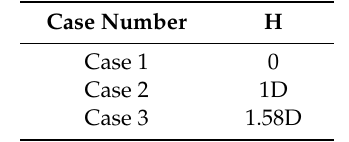
Table 3. Grid number in the computational domain and corresponding resolution in the focus region.